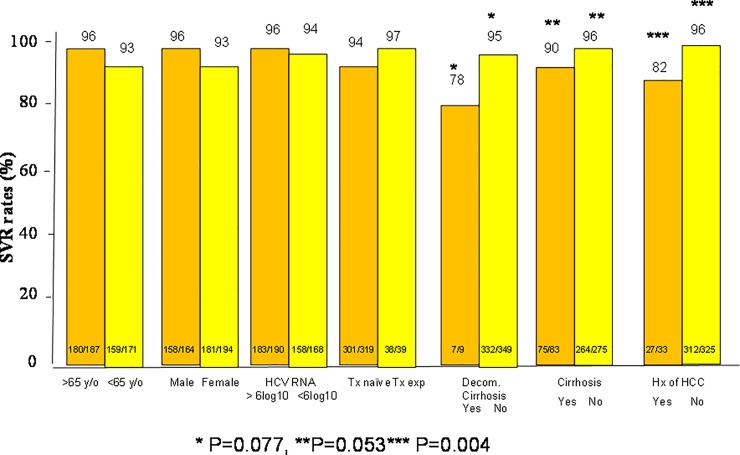
Subgroup analysis of the sustained virologocal response (SVR) rates in patients who received SOF/RBV regimen.SOF: sofosbuvir, RBV: ribavirin.